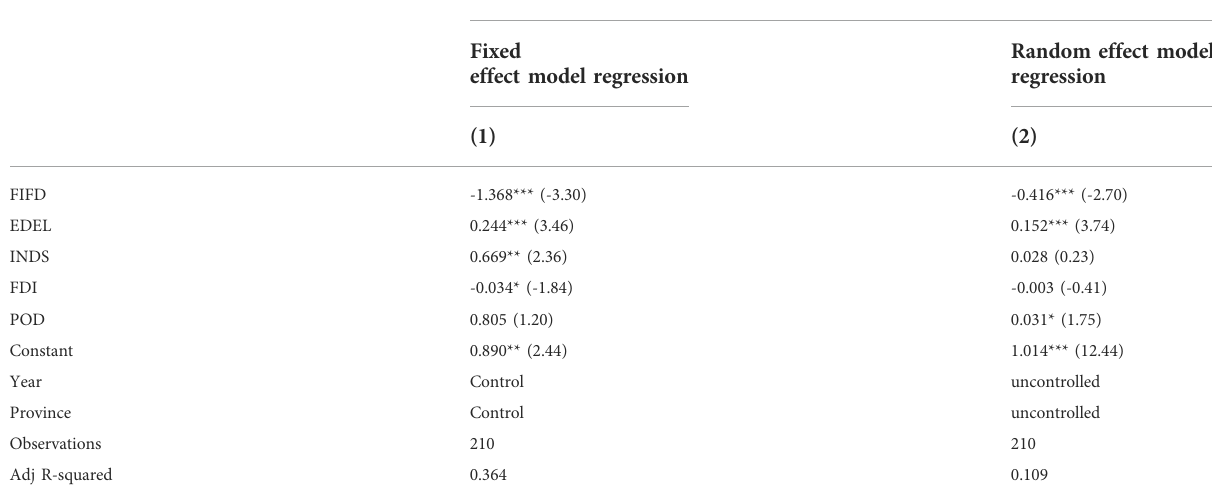
TABLE 8 Results of robustness